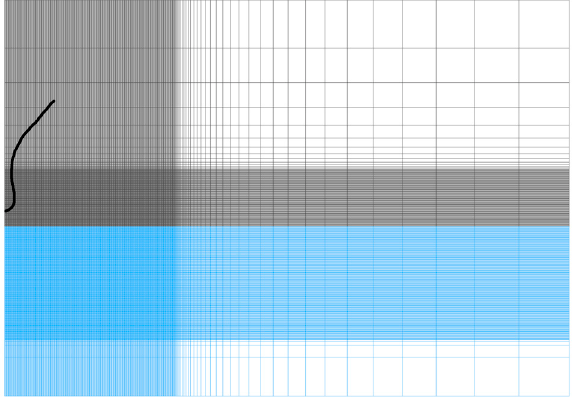
Figure 8. Grids for the section of the bow.